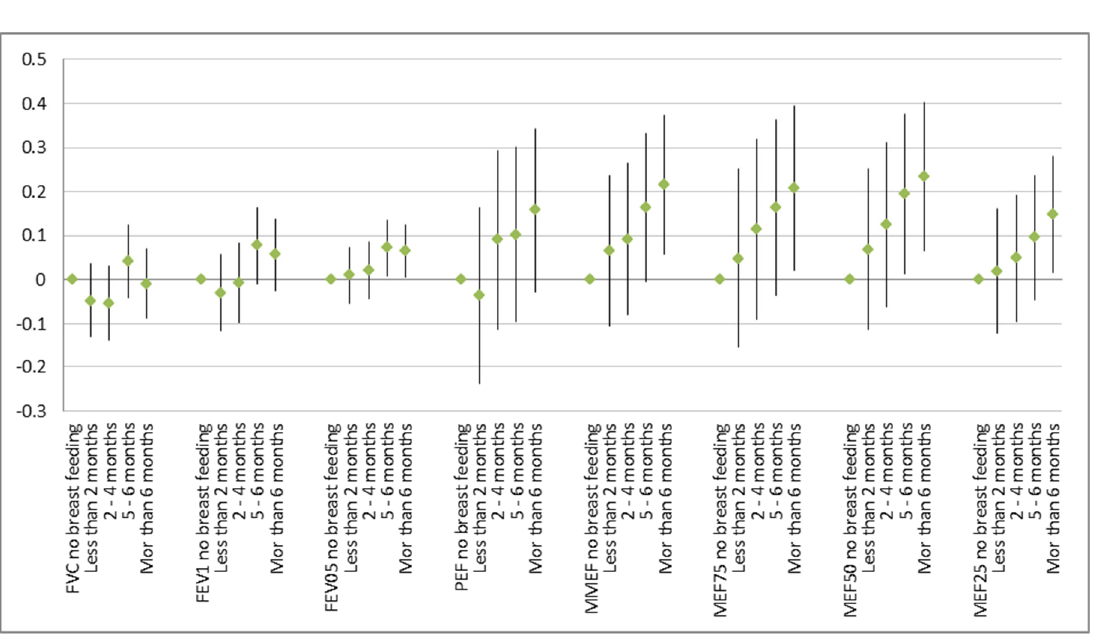
Figure 2. Effect of duration of breast-feeding on lung function in comparison to no breast-feeding: Point estimates and 95% confidence intervals in liter (FVC, FEV1, and FEV0.5) or in L/s.